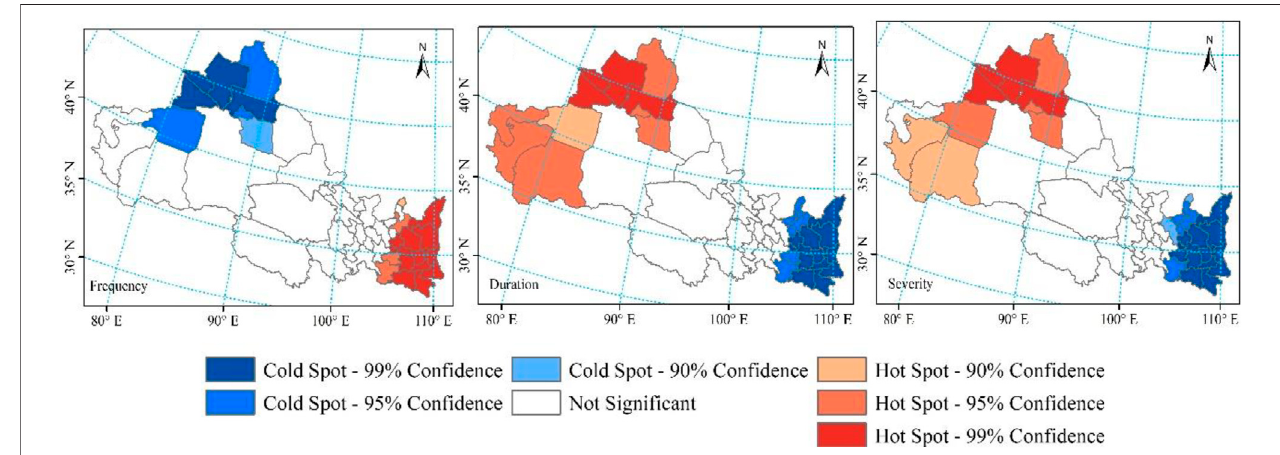
FIGURE 14 | Spatial autocorrelation pattern of annual drought